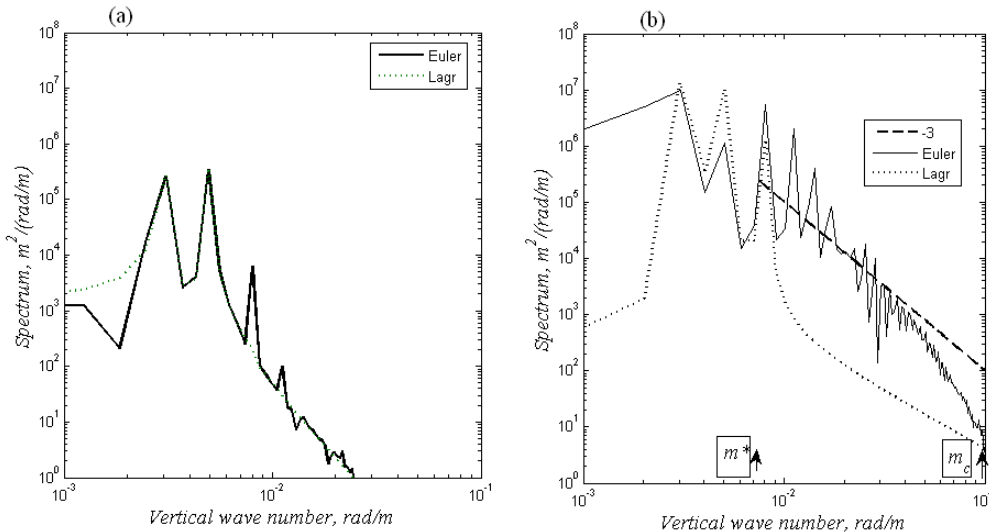
Fig. 3. Evolution of the vertical wave number spectra for the vertical profiles E(z) (continuous line) and L(c) (dotted line) with growing parameter of nonlinearity M 0 . (a) M 0 = 0 . 05 ,ν V = 12m. (b) M 0 = 0 . 44 ,ν V = 98m; the corresponding profiles are shown in Fig. 2. The straight dashed line corresponds to the observed power law decay βk − 3 z , β = 0 . 1. The wave numbers m ∗ and m c are indicated by arrows, where m ∗= 1 /( 2 1 / 2 ν V ) is the lower characteristic wave number above which the non-resonant interactions form spectral tail, and m c is the critical vertical wave number, at which wave energy dissipates due to wave-induced